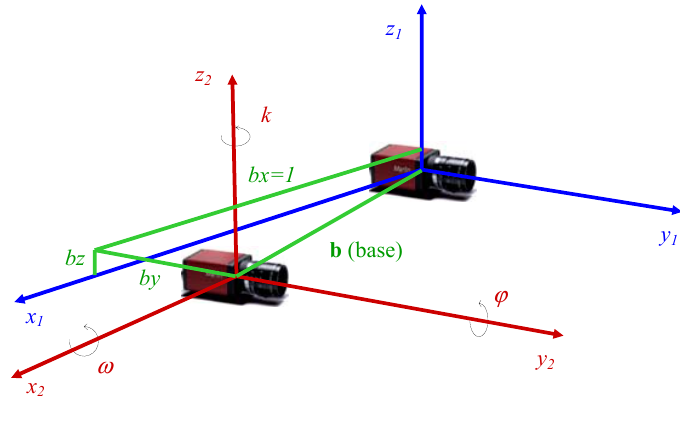
Figure 5. Relative orientation between two